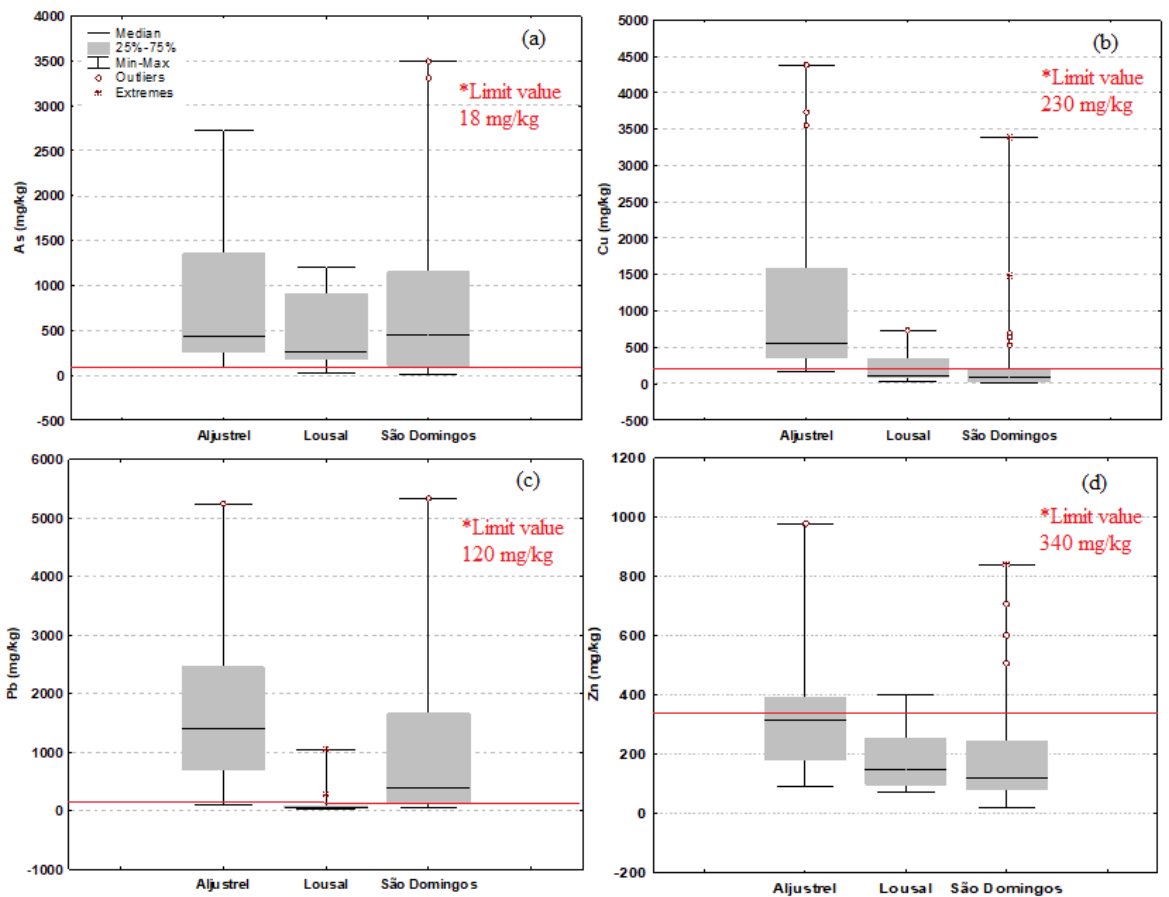
Figure 6. Boxplot representation of the pseudo-total concentrations (Aqua Regia extraction) of the most representative potentially toxic elements which affect pyrite mines in the Portuguese sector of the IPB (sampling campaign July 2016): Aljustrel (n = 14), Lousal (n = 12), São Domingos (n = 39). ( a ) As (mg/kg); ( b ) Cu (mg/kg); ( c ) Pb (mg/kg); and ( d ) Zn (mg/kg), all concentrations in a dry weight (DW) basis. The mark across the box represents the median and the bottom, and the top of the box represents the 25–75% interval. All results report to a dry matter basis. (*) Recommended limit values for the remediation of soil intended for industrial use from the APA Technical Guide are presented in red and also as a horizontal line [2].